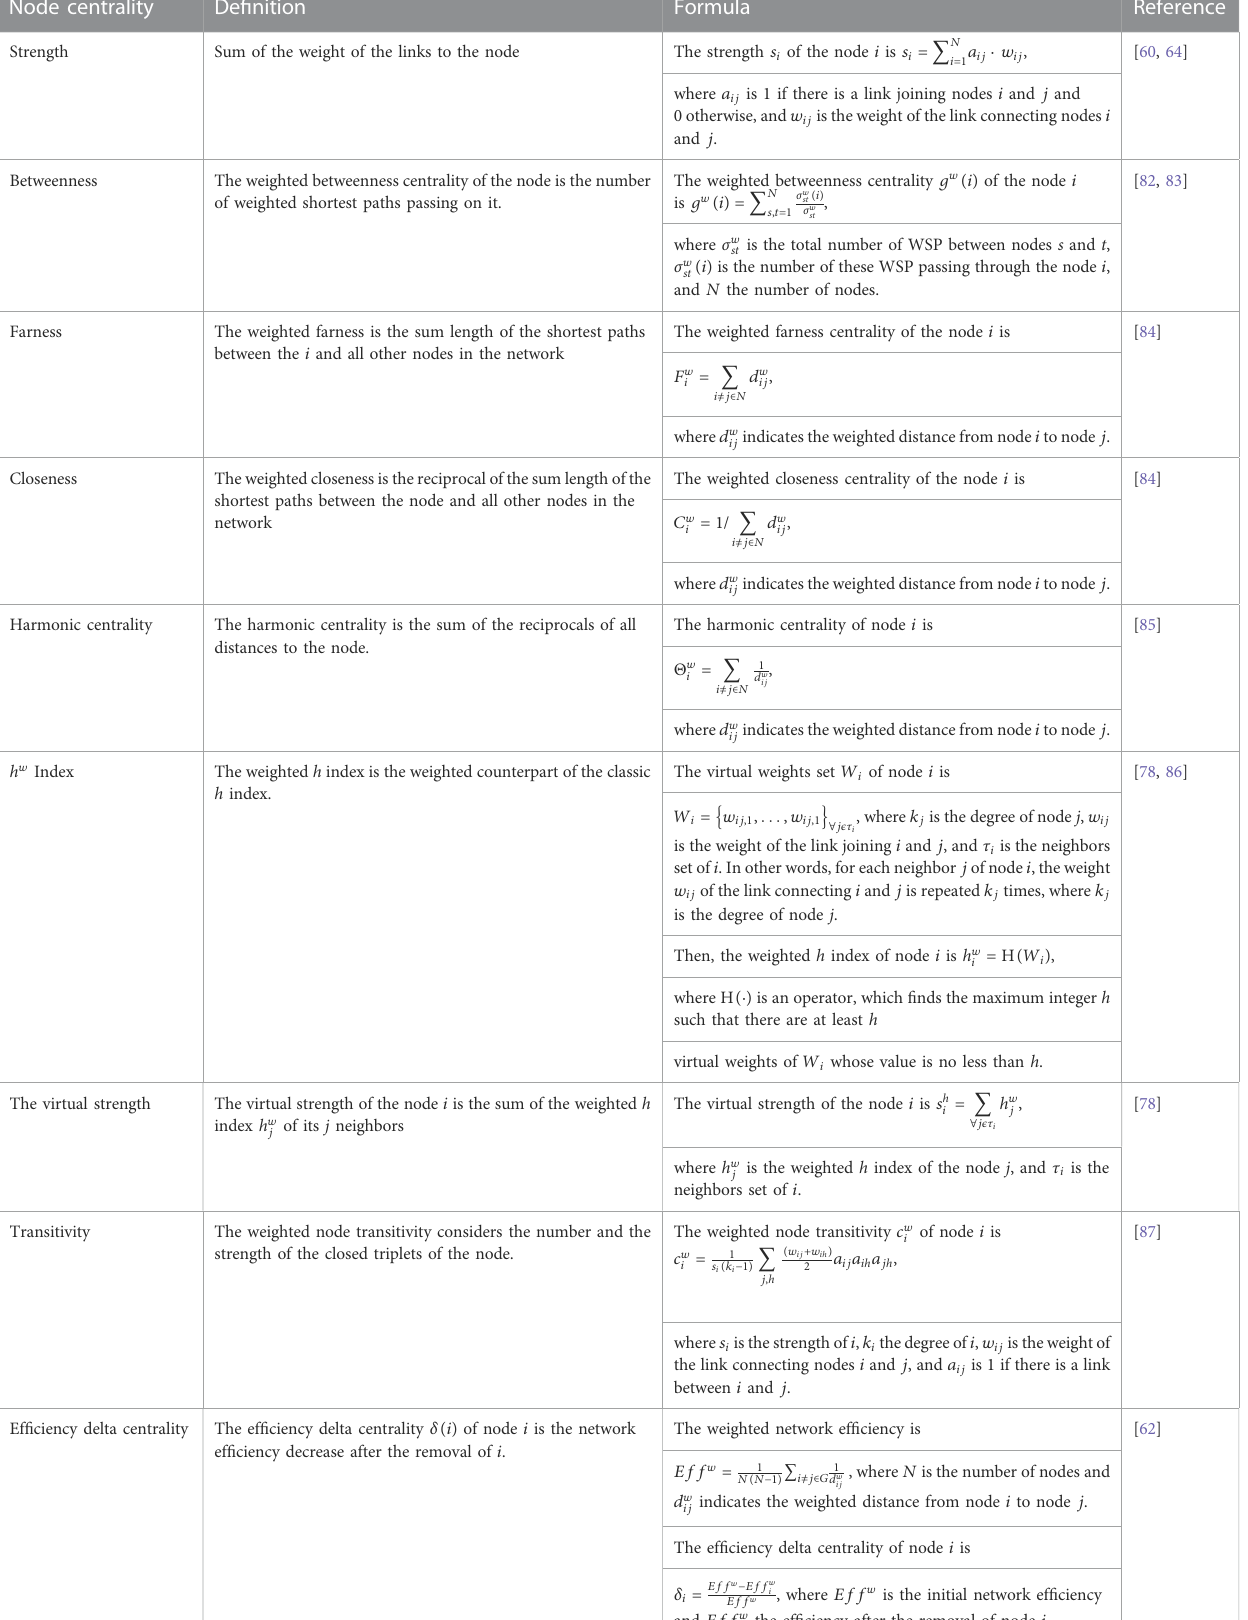
Theweightedclosenessisthereciprocalofthesumlengthofthe shortest paths between the node and all other nodes in the